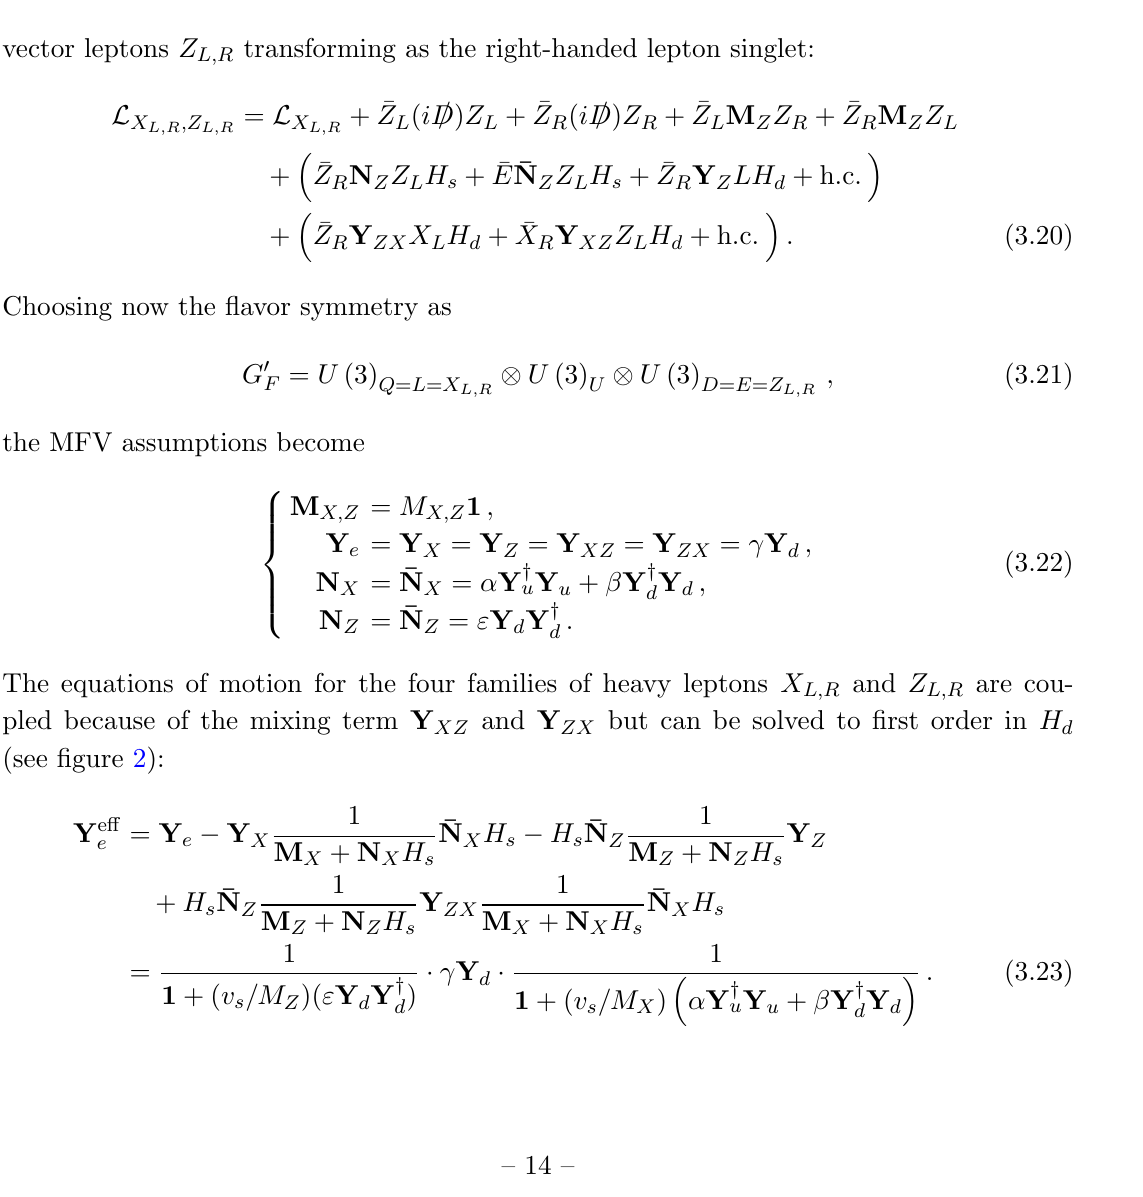
Figure 3 . Evolution of the singular values of Y e(cid:11) as given in eq. (3.17), i.e., induced by tree-level e exchanges of the vector leptons X L;R . The green dashed line indicates the point at which the singular values of Y e(cid:11) coincide with the observed lepton Yukawa couplings, and corresponds to the e values quoted in eq. (3.18). Compared to (cid:12)gure 1, it now sits at a perfectly regular point. The singular values are not (cid:12)ne-tuned since they do not change much as the Y e(cid:11) parameters vary. e